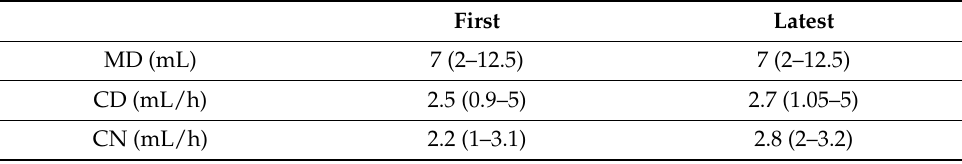
Table 4. LECIG infusion rates ( n = 24).